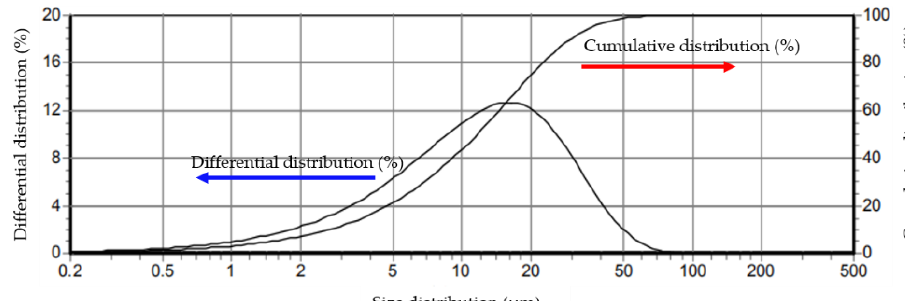
Figure 3. Dust particle size distribution.